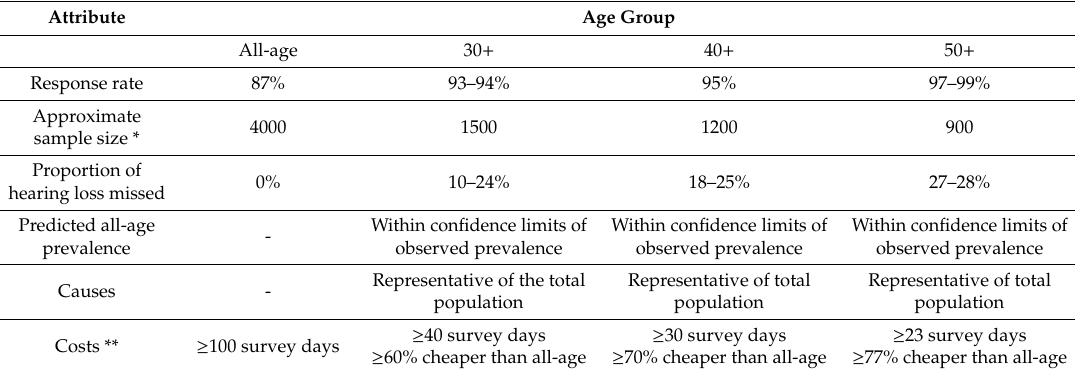
Table 4. Comparison of survey attributes for di ff erent age cut o ff s: 30 + ; 40 + ; 50 + years.